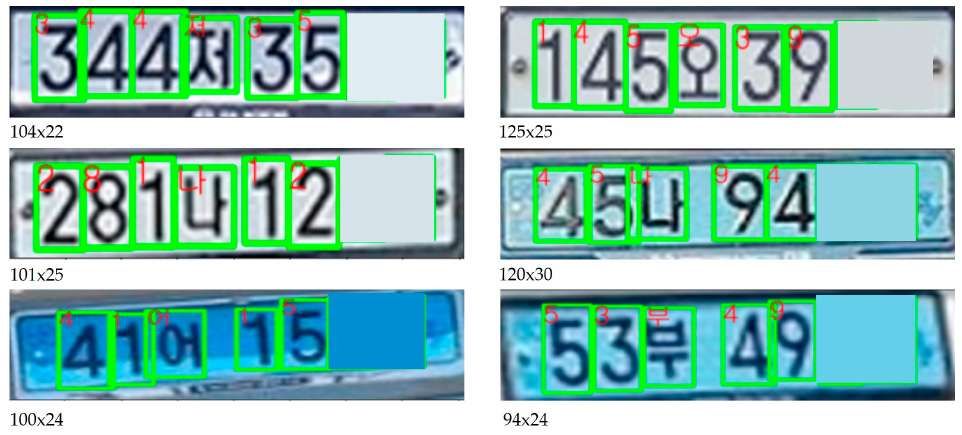
Figure 11. Examples of character recognition results. Two characters were masked due to privacy policies.